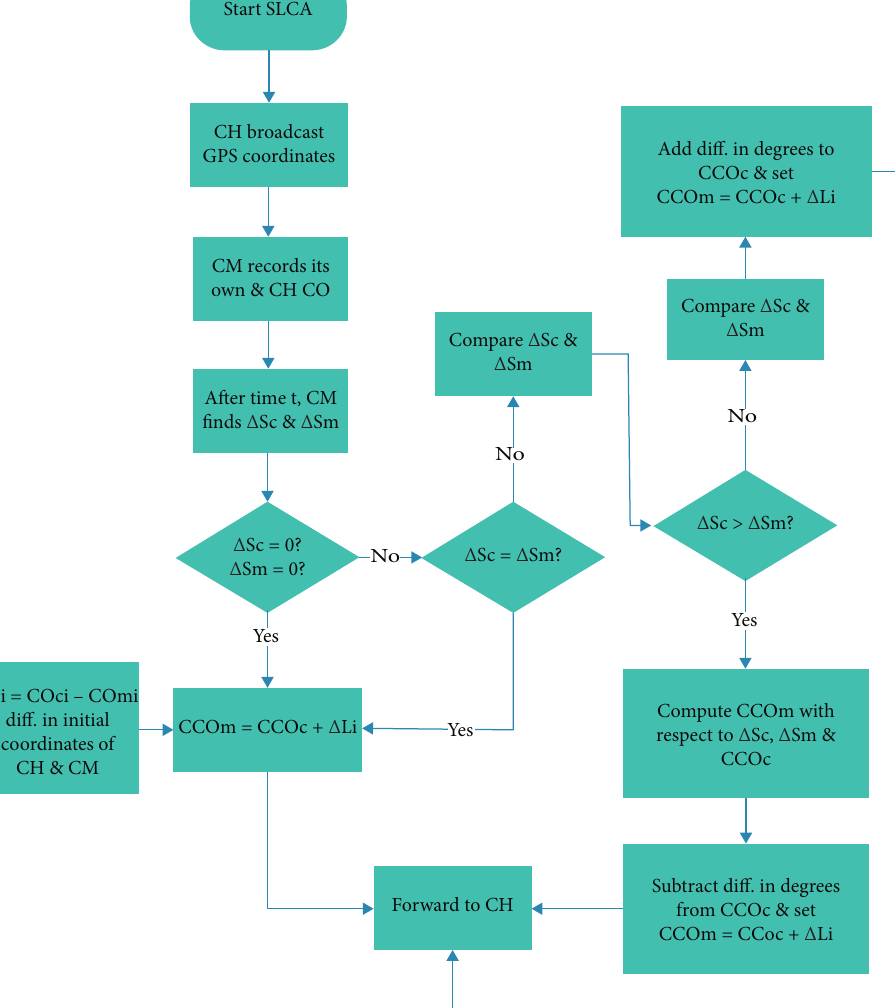
Figure 3: Flow diagram of self-location calculation